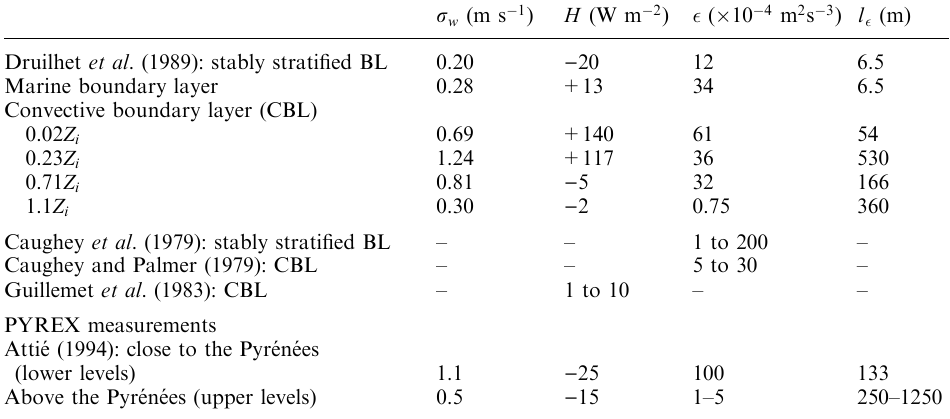
Table 2. Characteristic values of various turbulence para- meters measured in stably stra- tified boundary layer, convective boundary layer and during PYREX: standard de- viation of vertical velocity ( (cid:114) w ), sensible heat flux ( H ), dissipa- tion rate of TKE ( (cid:15) ) and inertial length-scale ( l (cid:15)